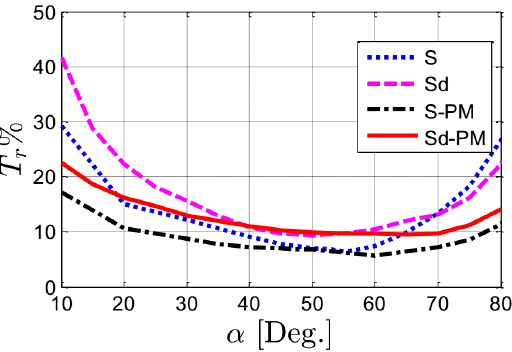
Figure 11. SynRM torque ripple ( T r %) as a function of current angle ( α ) at rated current and speed.